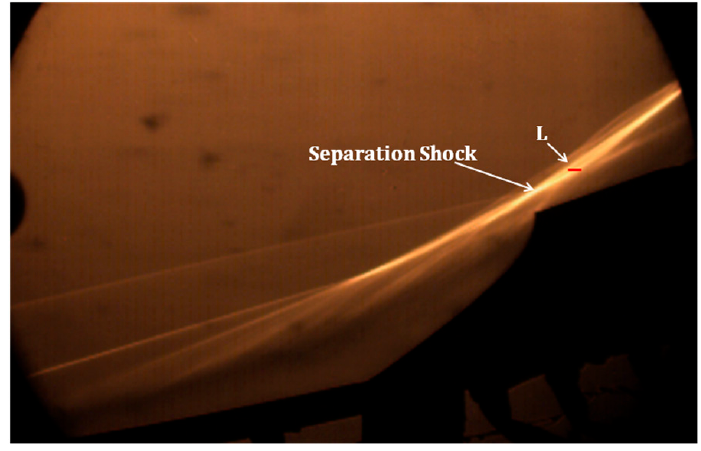
Figure 8. Short line of grayscale detection.